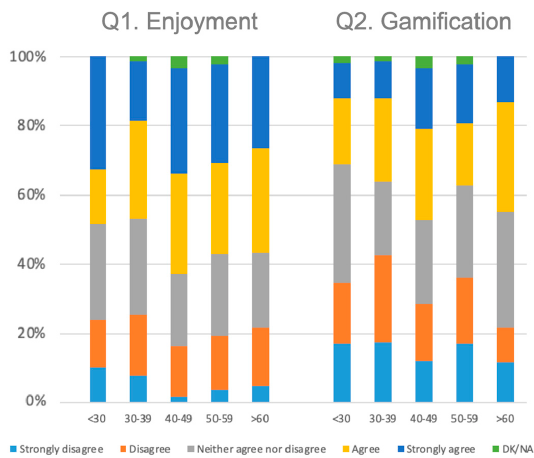
Figure 7. Relationship between learning, enjoyment, gamification and age.